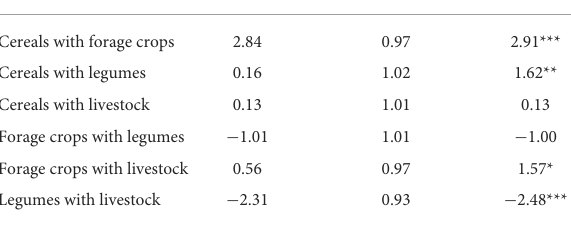
TABLE 5 Empirical coefficients of the cross-products of outputs in the input distance function. Variables Estimates Standard deviation t-